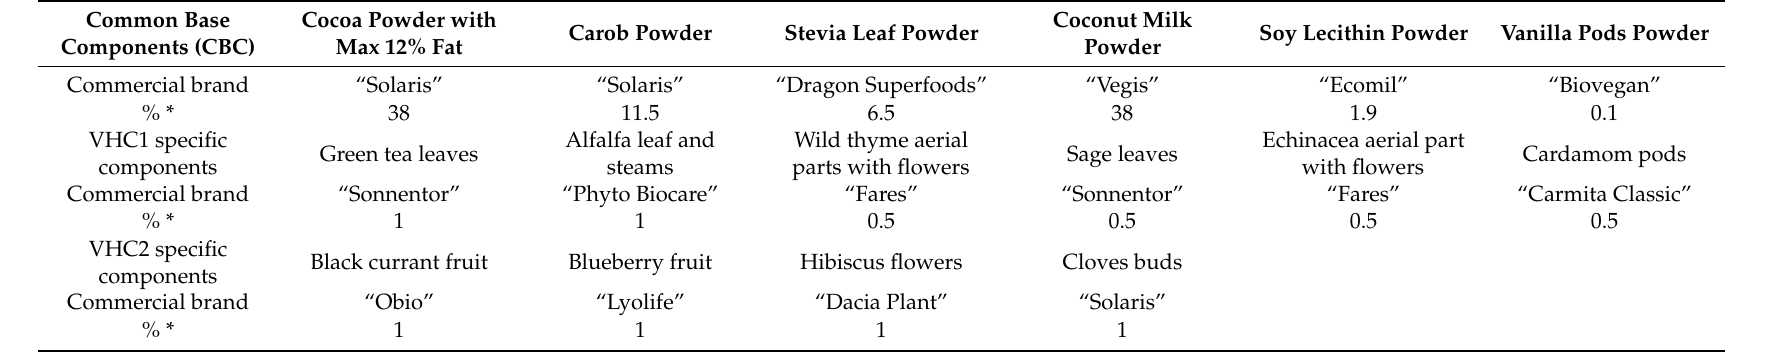
Table 1. Recipes for hot chocolate powder variants: vegan hot chocolate 1 (VHC1) and vegan hot chocolate 2